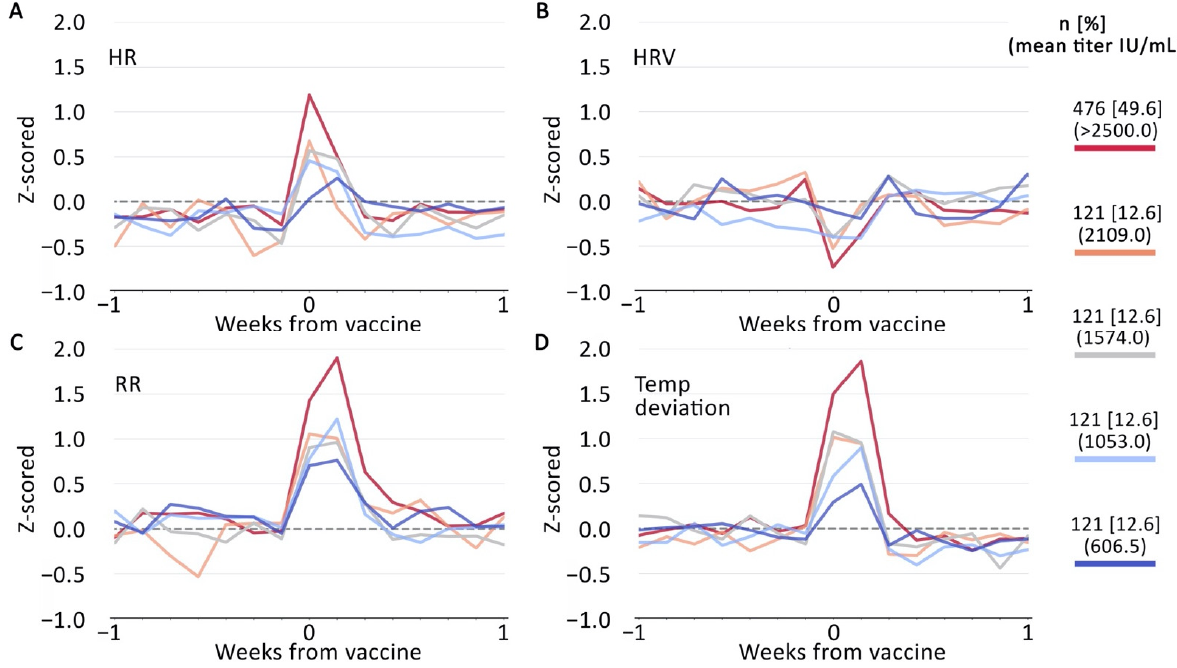
Figure 2. Plots depicting ( A ) changes in heart rate (HR); ( B ) heart rate variability (HRV); ( C ) respir- atory rate (RR); and ( D ) temperature deviation the nights surrounding the second injection for Pfizer-BioNTech and Moderna-NAIAD vaccine recipients, combined, Values are z-scored for par- ticipants’ pre-vaccination baseline period (see Materials and Methods).